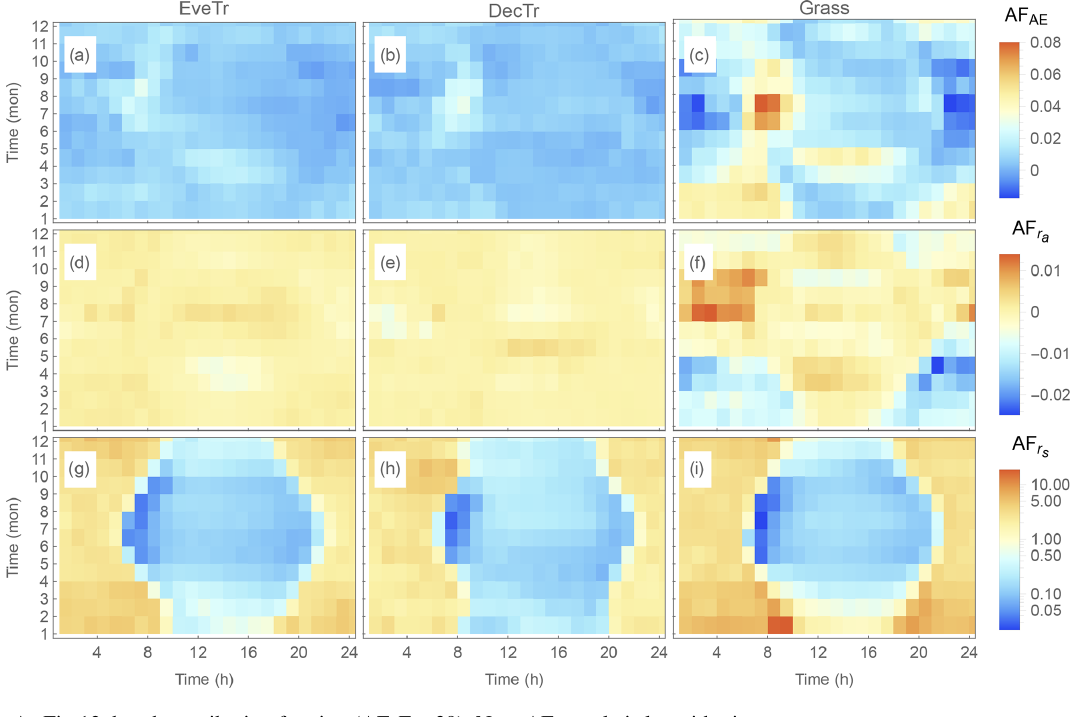
Figure 13. As Fig.12, but the attribution fraction (AF, Eq. 39). Note AF rs scale is logarithmic.